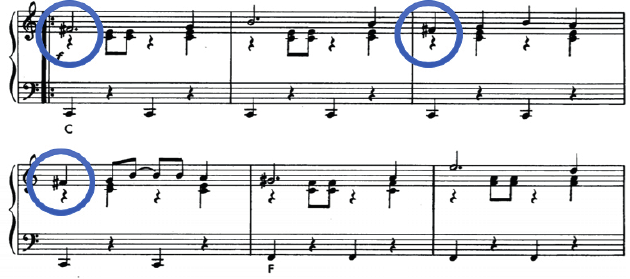
Figure 1. The Lydian notes in Borsalino’s main theme (source: created by the author)